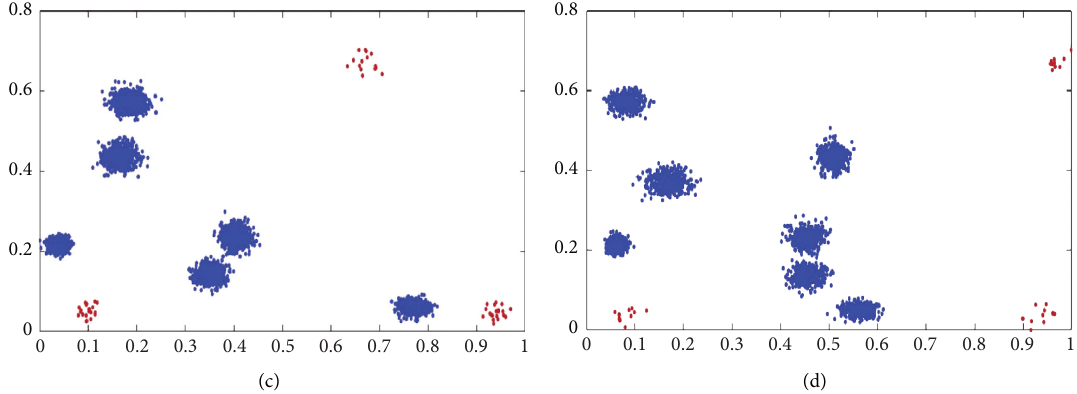
Figure 3: Two-dimensional illustrations corresponding to four synthetic data sets (the red data points are outliers.). (a) Data set 3 (five